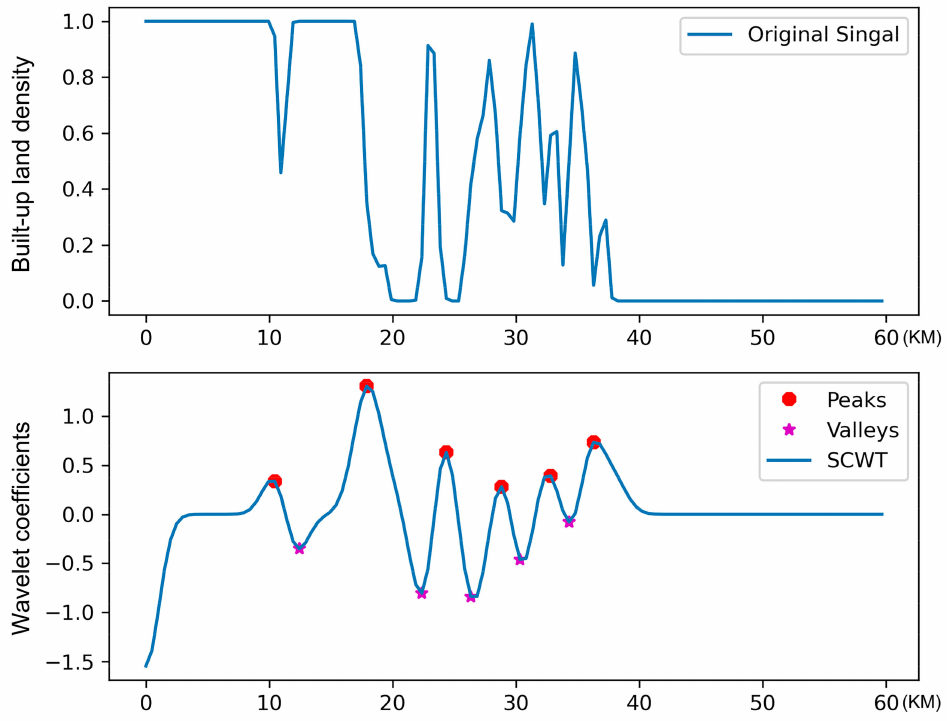
Figure 6. Process of spatially continuous wavelet transform (taking the built-up land density of the 216 ◦ transect as an example).